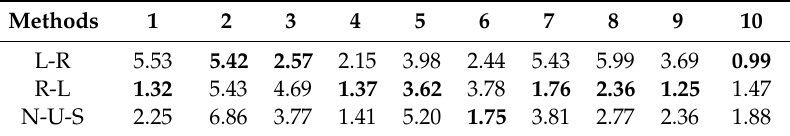
face. The RMSE results are shown in Table 7. The optimal situation is expressed in bold. Table 7. Comparison of the effect of the symmetrical substitution method in the frontal face (L-R = replace right cheek with left cheek; R-L = replace left cheek with right cheek; N-U-S = No use of symmetrical substitution).